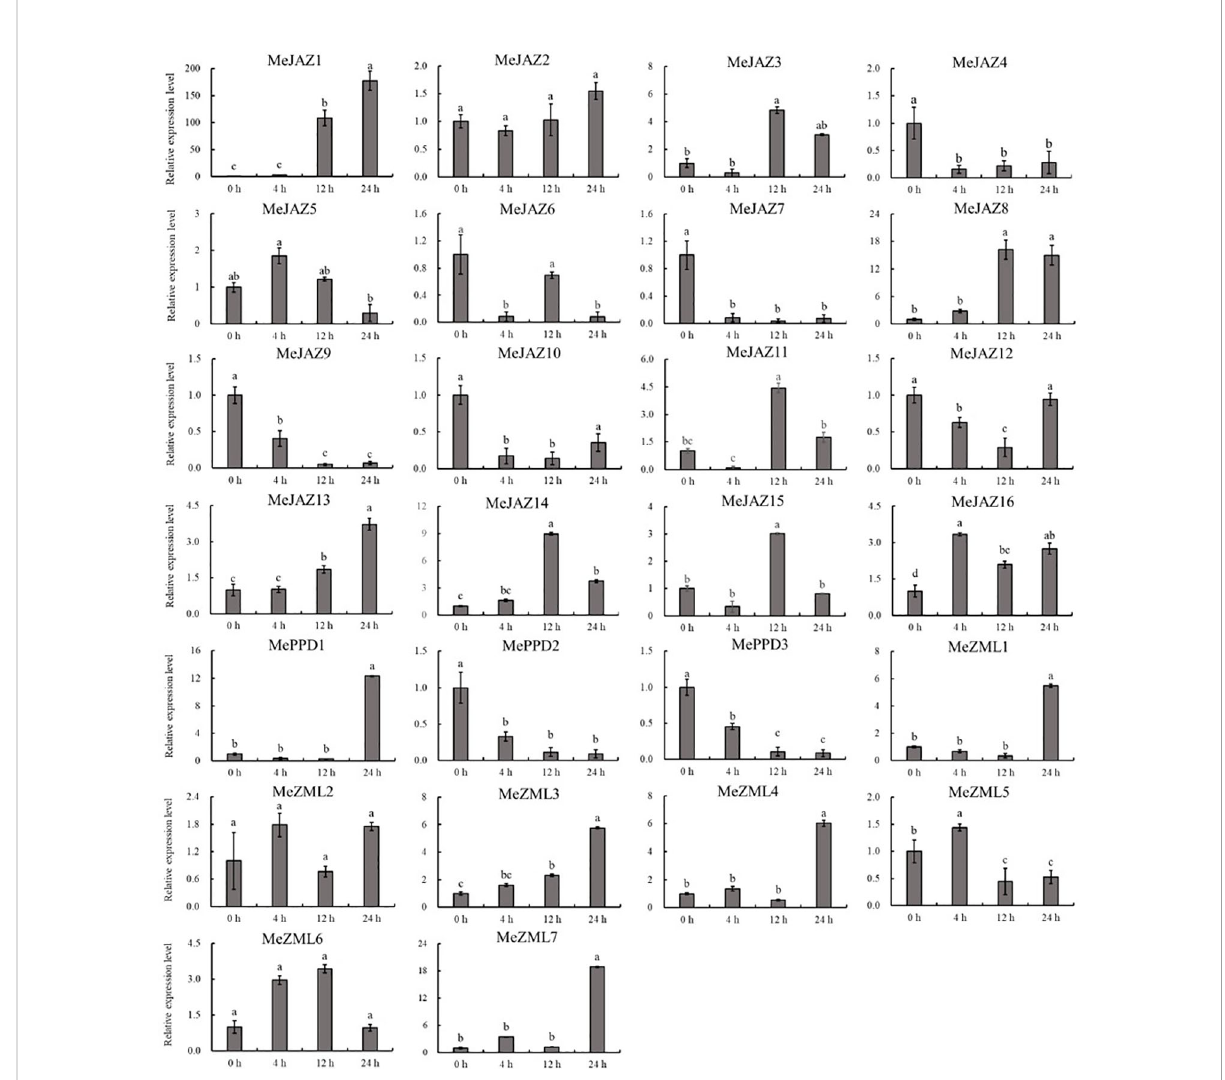
FIGURE 8 Expression pro fi les of 26 ZML , PPD and JAZ genes in response to osmotic stress in cassava as determined by qRT-PCR. The error bars represent the standard error of the means of three independent replicates. Values denoted by the same letter did not differ signi fi cantly at P < 0.05 according to Duncan ’ s multiple range